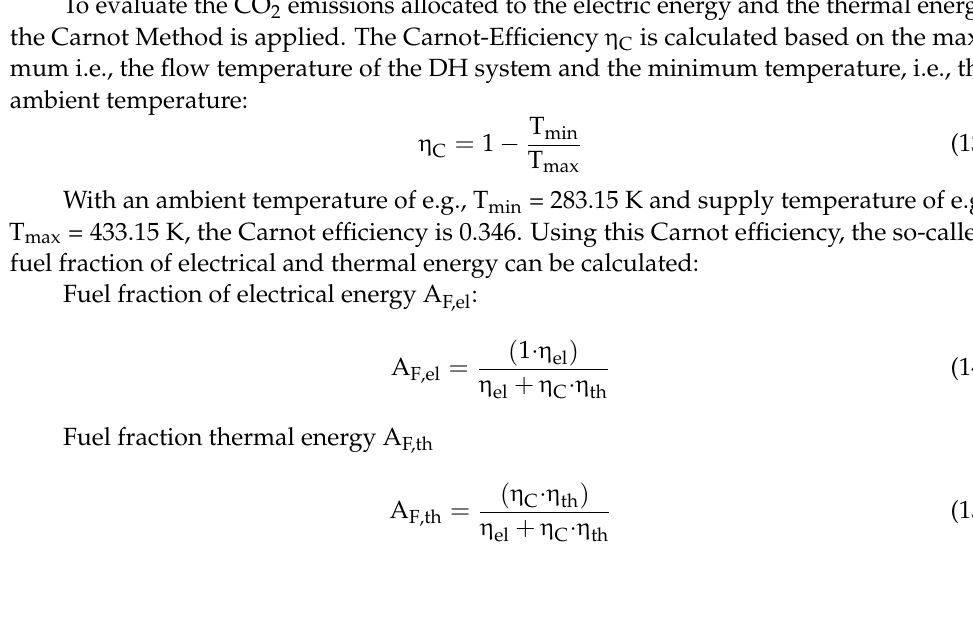
Figure 12. CO 2 conversion factors for electricity according to two scenarios of a generic electricity mix with 10% hydro, 10% wind and 10% PV and 10% hydro, 30% wind and 30% PV, respectively (residual fossil), according to [29].